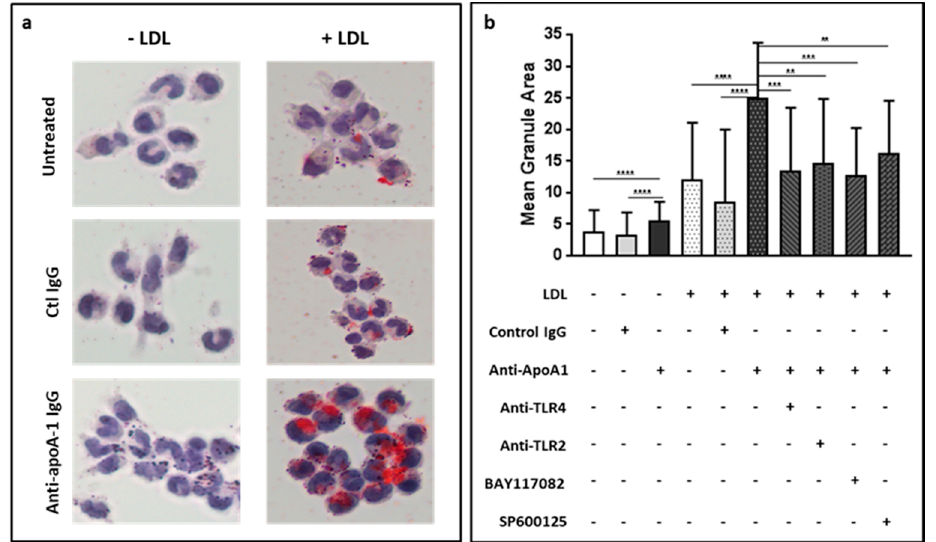
Figure 5. Anti-ApoA-1 IgG promote LDL uptake and foam cell formation mediated by TLR2 / 4, NF-kB, and AP1. ( a ) HMDM were treated for 24 h with anti-ApoA-1 IgG or ctl IgG in the presence or absence of native LDL (20 µ g / mL). Cells were stained with Oil Red O to highlight the lipid uptake. ( b ) Blocking antibodies to TLR2 / 4 were used as well as inhibitors to NF-kB and AP-1 to try to inhibit the anti-ApoA-1 IgG mediated LDL uptake as evidenced by Oil Red O staining quantification as the mean granule area per cell. Oil Red O was quantified as indicated in the method section. Results are expressed in arbitrary units as mean ± SD of four independent experiments ( n = 4), p -values were calculated using the Student’s t -test: ** p < 0.01, *** p < 0.001, **** p < 0.0001.